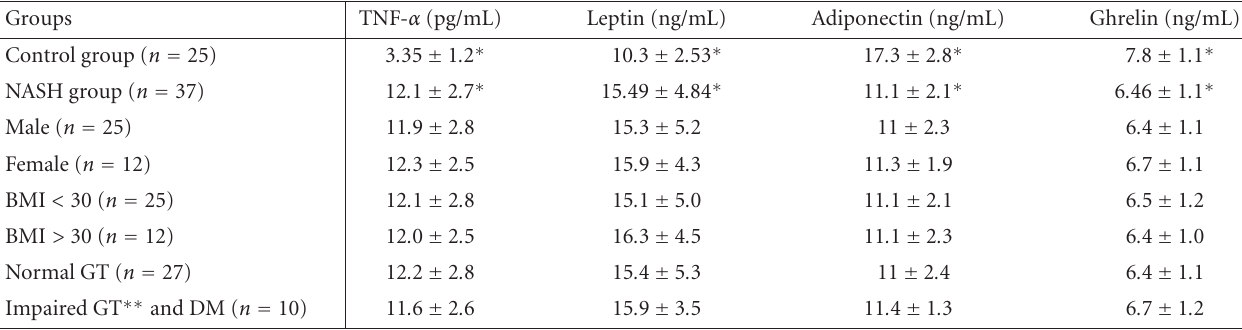
Table 2: Data of the serum TNF- α , leptin, adiponectin, and ghrelin values in control and NASH groups and in di ff erent subgroups of the NASH